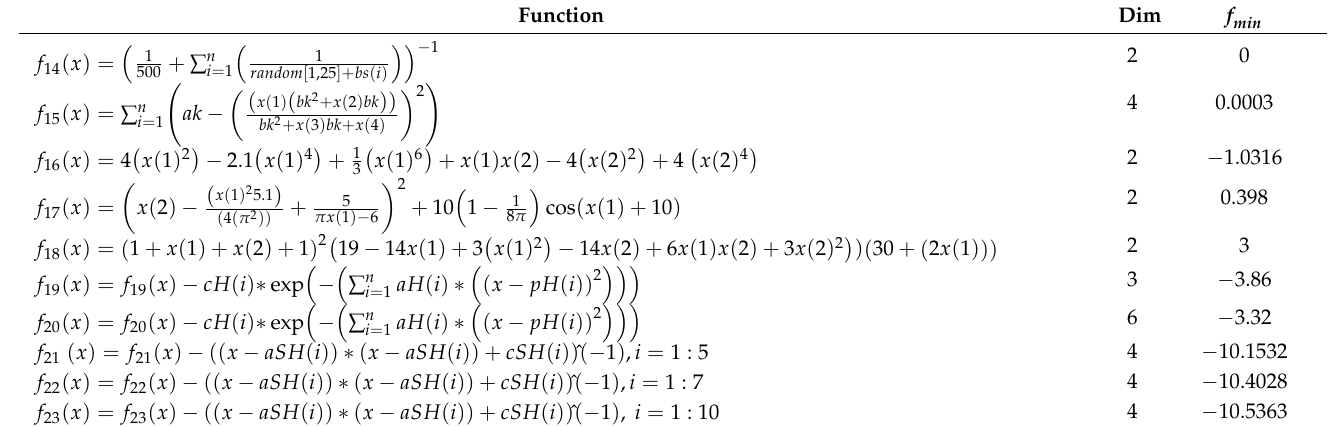
Table 3. Complex functions. Function